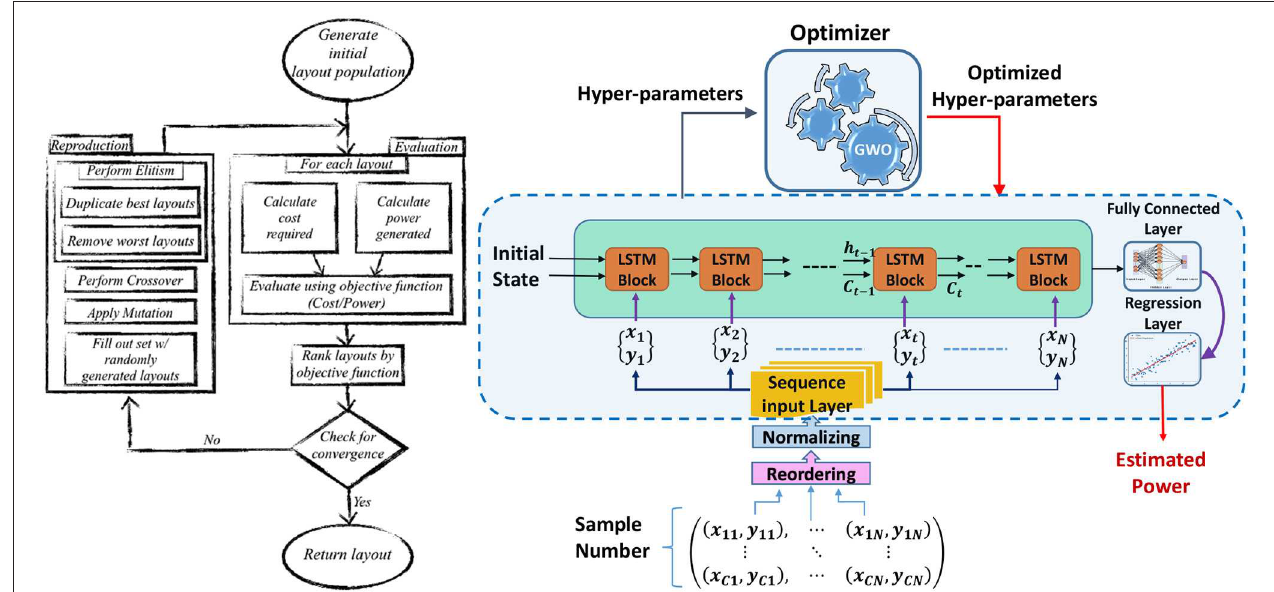
FIGURE 6 | (Left) A flowchart of the genetic algorithm used by Sharp and DuPont (2018). (Right) The neuro-surrogate model of Neshat et al. (2019a) used to estimate the power production in wave energy parks.